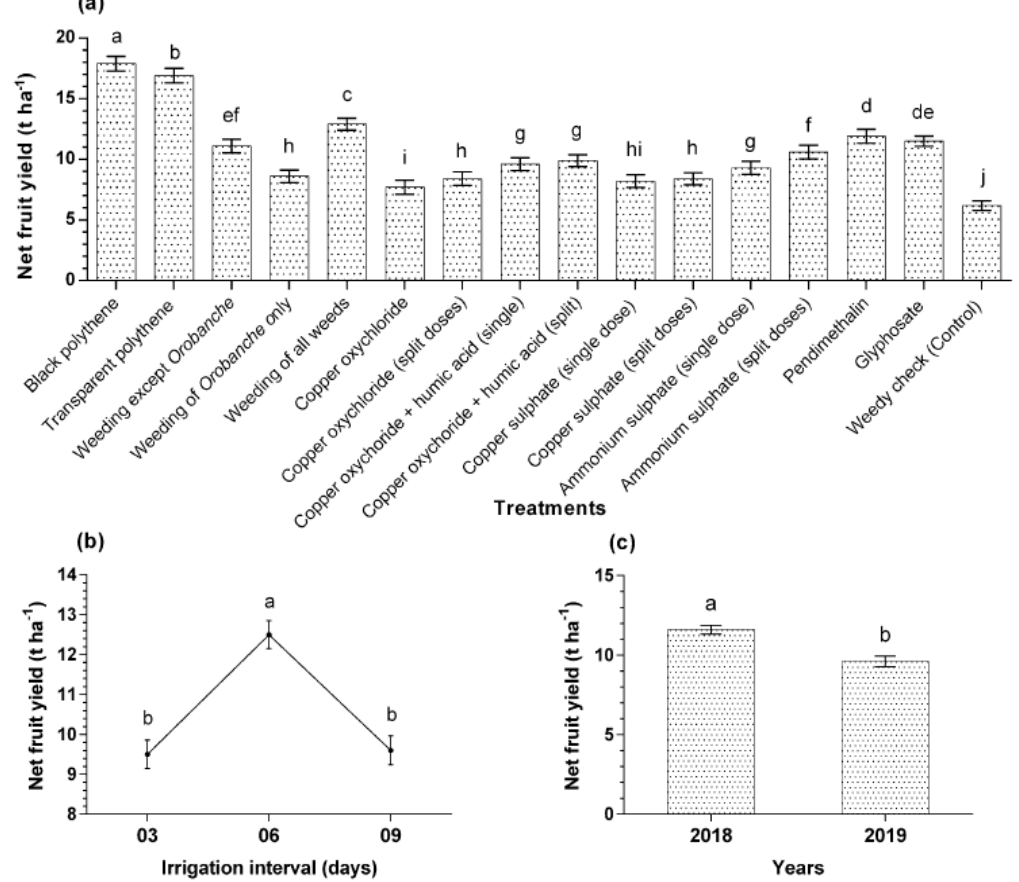
Figure 13. Effect of irrigation intervals and weed management treatments on net fruit yield of tomato. Based on the Least significant difference test, line and column ± standard error followed by different alphabetical letters are significantly different from each other at a 5% level of probability . ( a ) Effect of treatments on net fruit yield of tomato. ( b ) Effect of irrigation intervals on net fruit yield of tomato. ( c ) Effect of different years on net fruit yield of tomato.